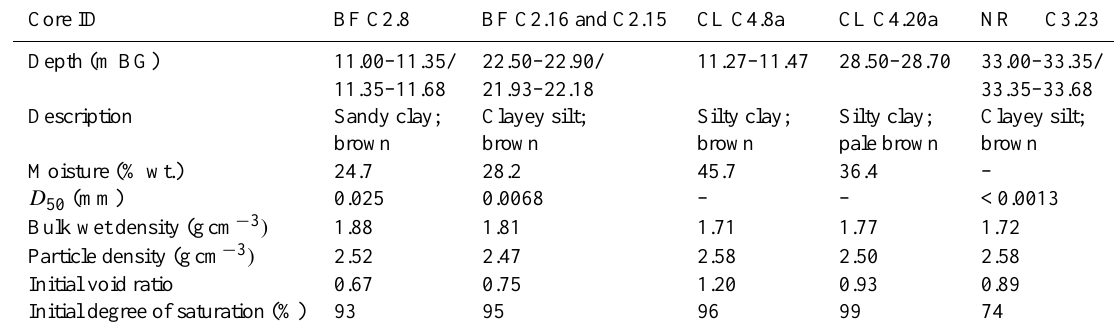
Table 2. Core descriptions and index properties.